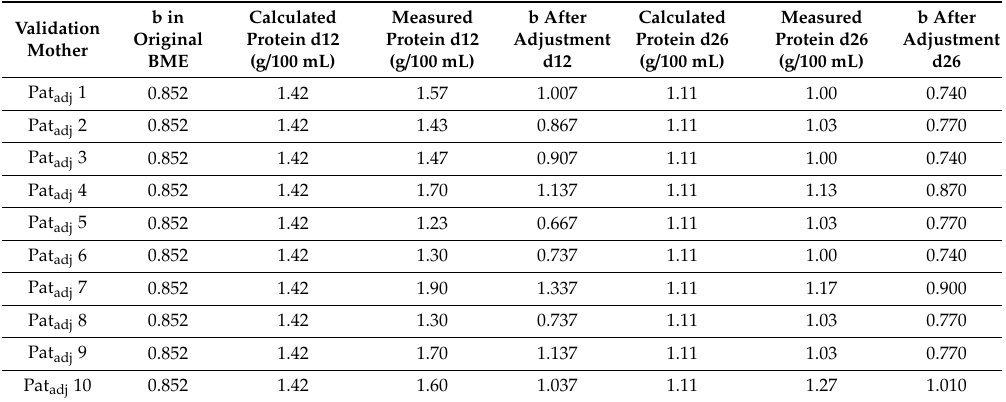
Table 3. Adjustments of the breast milk-equation (BME) in the validation cohort (10 mothers; Pat adj 1–10) based on actual measured protein content. Protein content calculated for day 12 (1.42 g/100 mL) and day 26 (1.11 g/100 mL) are listed along with the actual measured content and resulting modification of b (‘b after adjustment’) in the equation y = a/x + b.